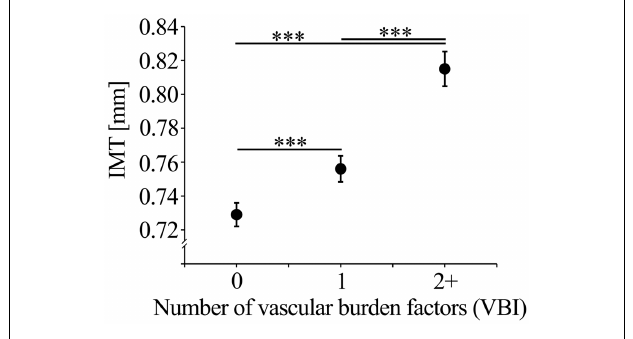
FIGURE 1 | Mean IMT (with standard error of the mean; SEM) corrected for age, sex, and education of theVBI groups